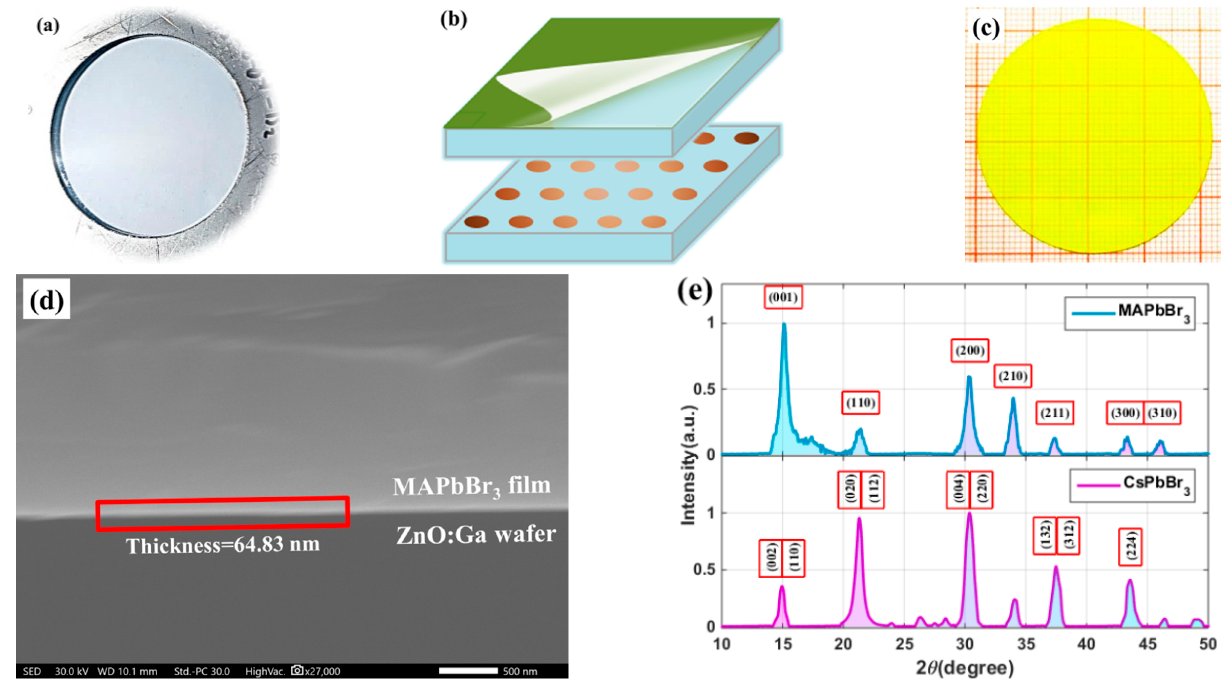
Figure 2. Pictures and structures of two-layer composite samples: ( a ) ZnO:Ga (GZO) wafer; ( b ) two typical combination ideas; ( c ) two-layer composite sample; ( d ) micrograph of the two-layer sample; ( e ) XRD pattern of the perovskite film and GZO.